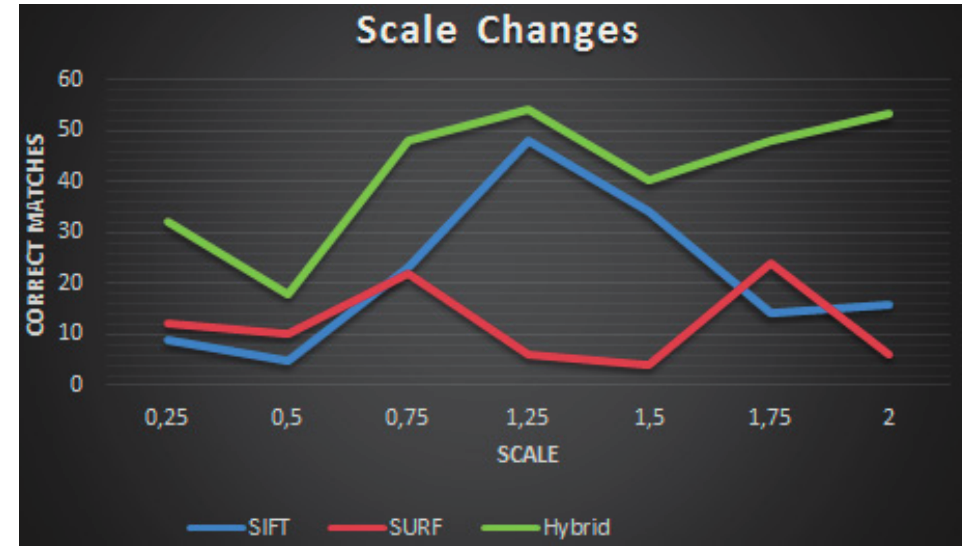
Figure 2. Scale changes.